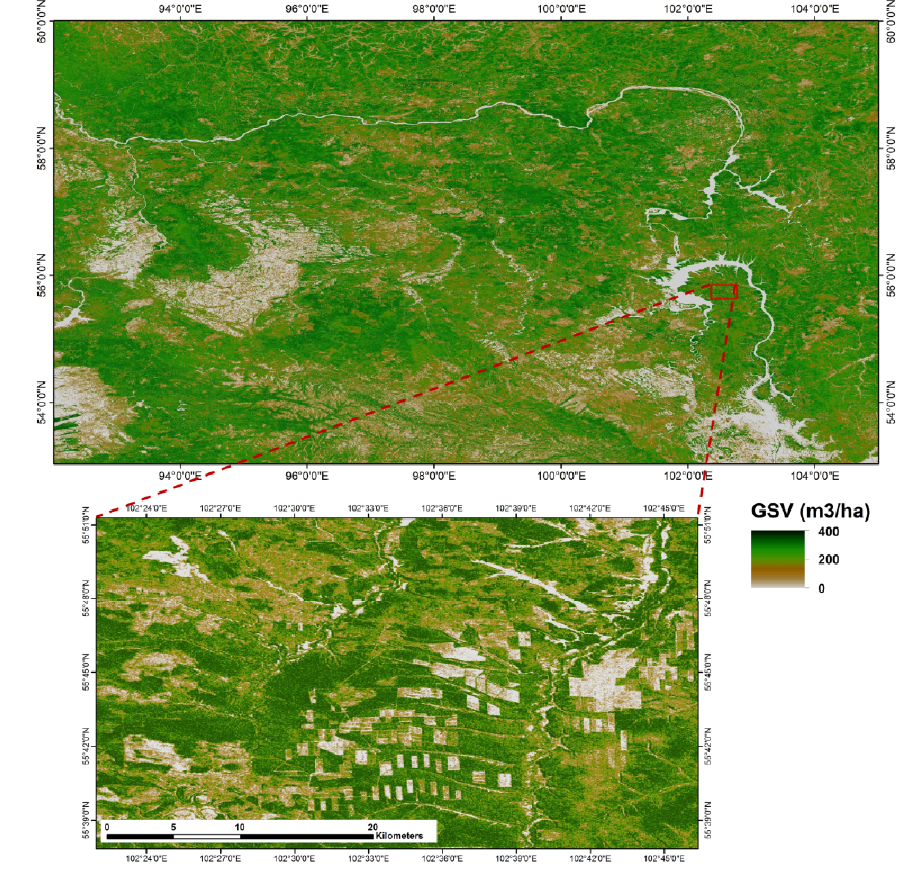
Figure 4. Growing stock volume (GSV) mapping result of the multi-temporal approach highlighting a subset of a heterogeneous forested area, including dense forest, sparse forest and clear cuts (clearly identifiable by their unnatural geometric shape).